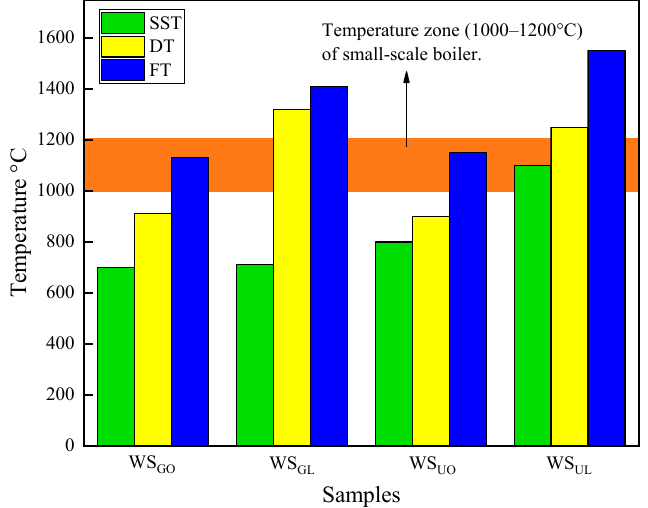
Figure 2. Melting temperatures of original and leached samples. The results concerning WS UO and WS UL were obtained from Yu et al. [25], for comparison.